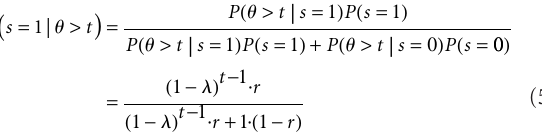
Figure 3 | graphical model for sensory input generation in our Bayesian model. Two separate streams of observations, { x 1 , … ,x t , … } and { y 1 , … ,y t , … }, are associated with the go and stop stimuli, respectively. x identity of the target, d ∈ {0,1}. y t depends on whether the current trial is a stop trial, s = {0,1}, and whether the stop signal has already appeared by time t , z t